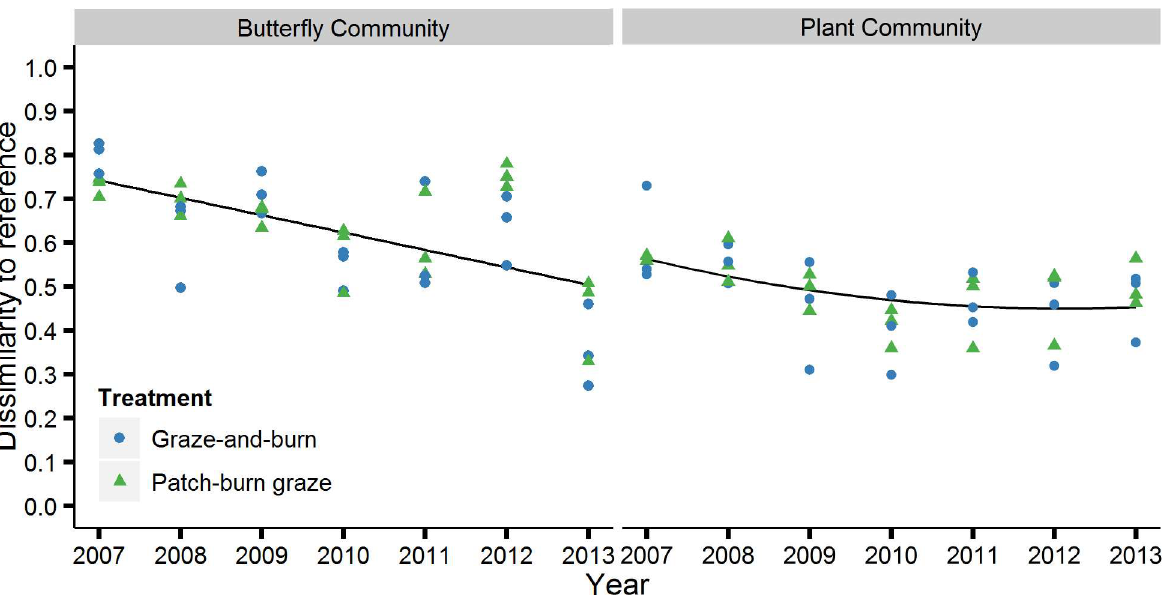
Fig 1. Convergence (i.e., declining dissimilarity) of butterfly community and plant community within degraded sites to reference sites over time. The dissimilaritymeasure on the y-axis is Bray-Curtis Dissimilarity, which was calculated as the dissimilarity between each grazed site and the average of the two reference sites for each year. See Table 3 for test of the response of decreasing dissimilarity over time.